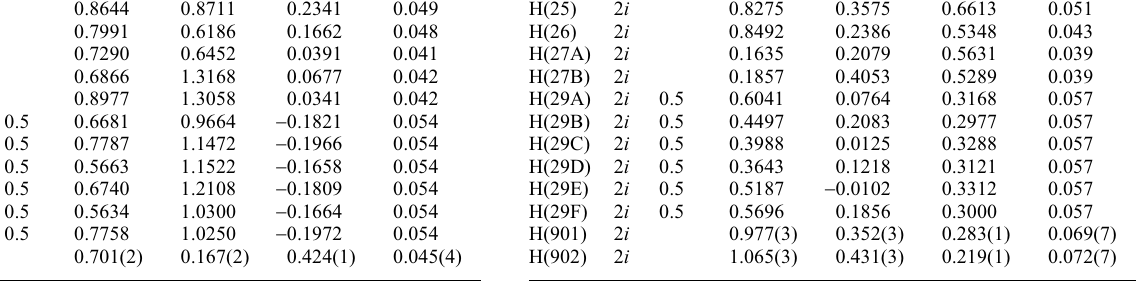
Table 3. Atomic coordinates and displacement parameters (in Å 2 )